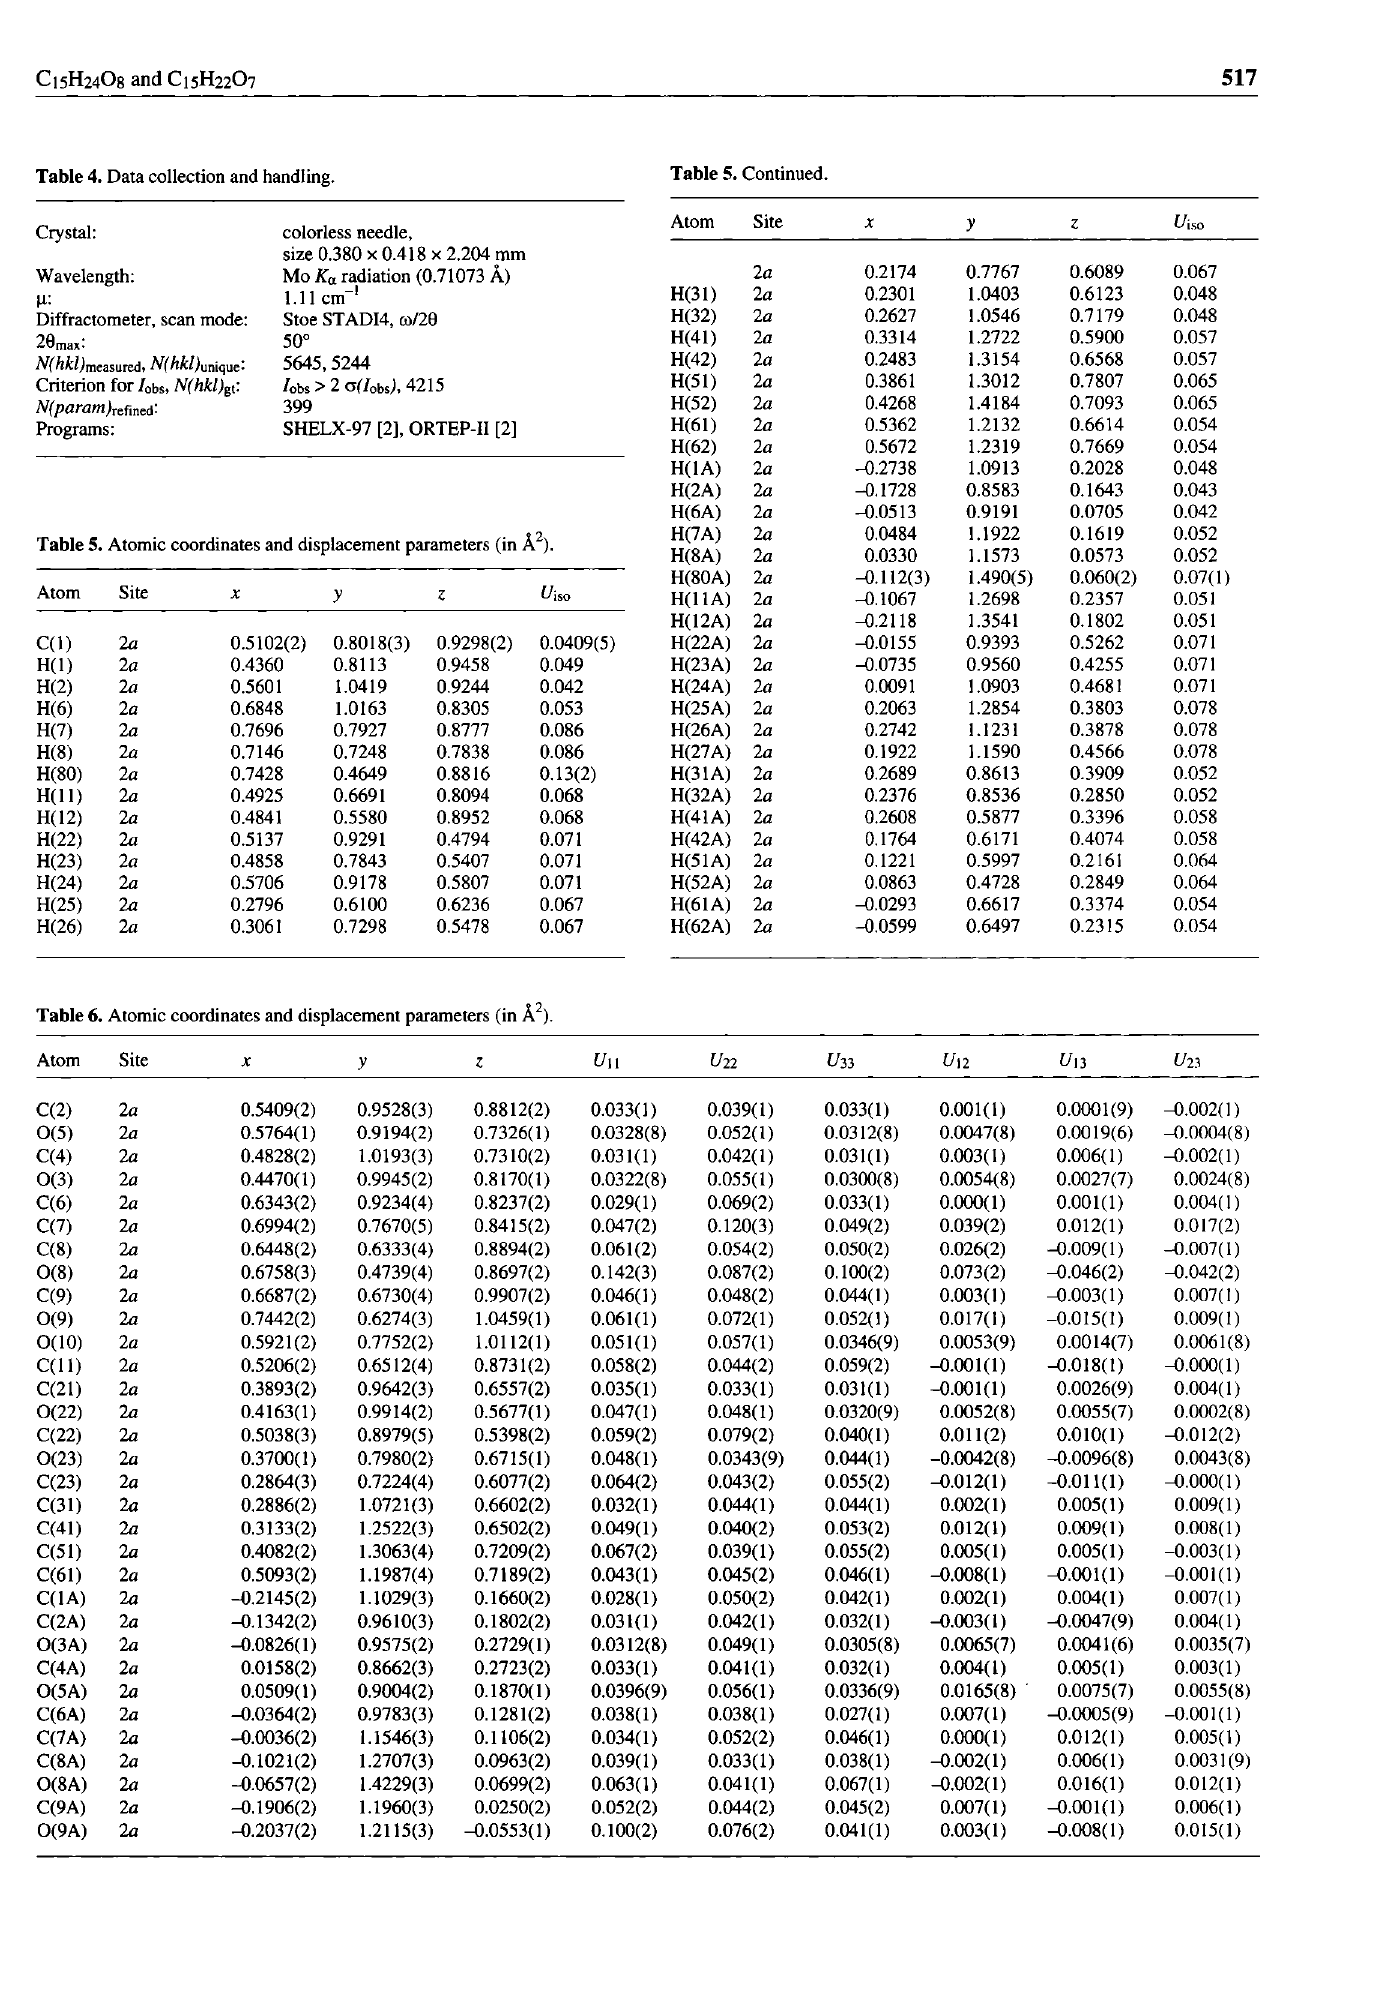
Table 5. Atomic coordinates and displacement parameters (in Â 2 ).